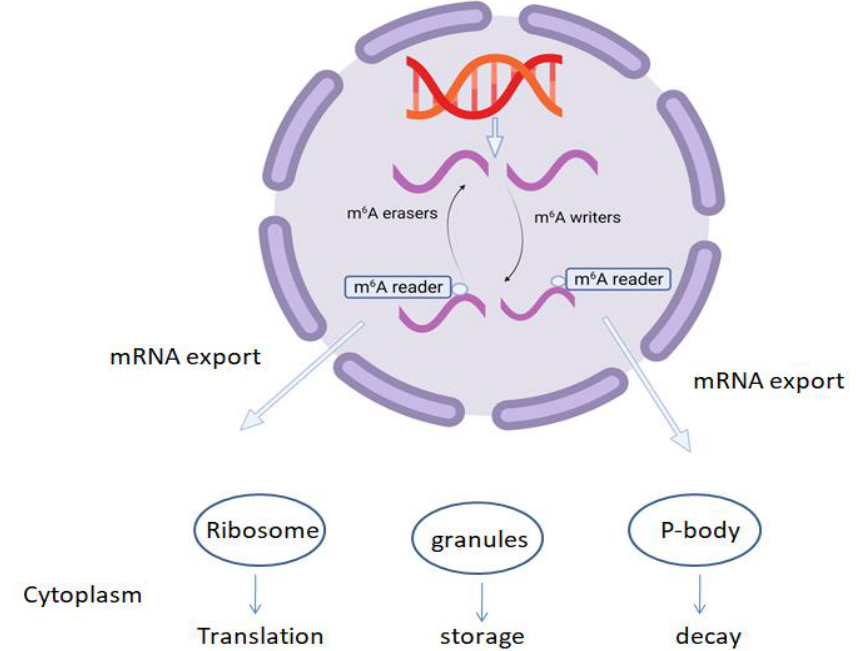
Figure 2. Various cellular processes affected by m 6 A RNA methylation; m 6 A RNA reader proteins determine the fate of modified transcripts and direct their export from the nucleus to the cytoplasm, where transcripts may be translated by the ribosomes, and stored in the granules, or decayed by the P-bodies.